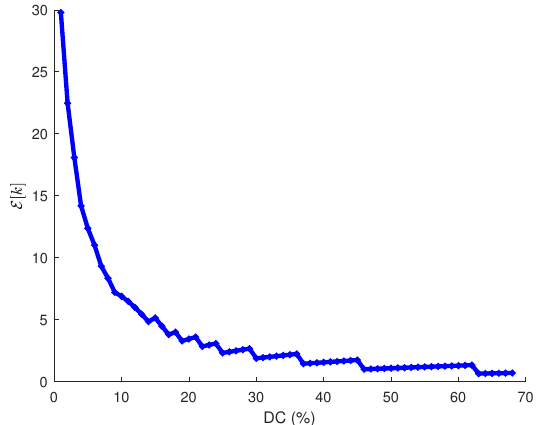
Figure 18. Expected number of tries in terms of the duty cycle.